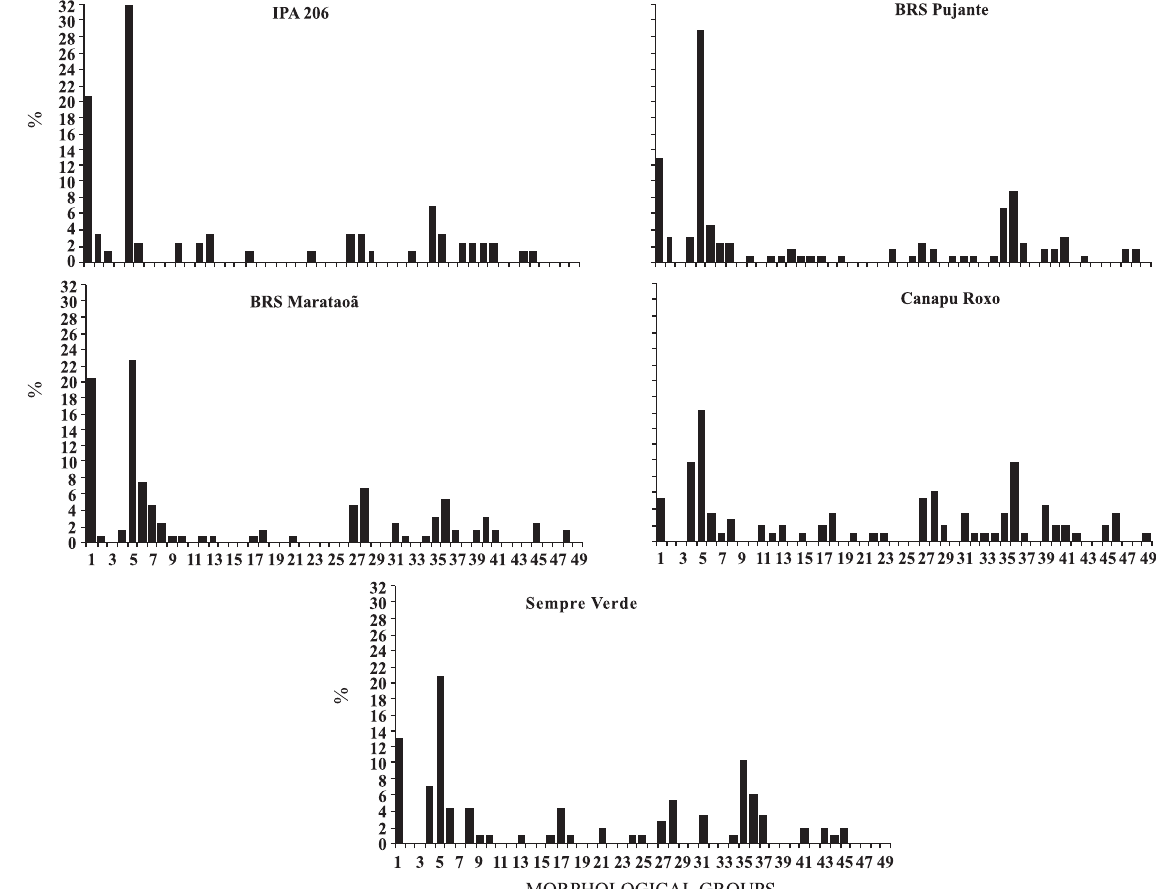
Figure 2. Frequency of rhizobium groups in cowpea cultivars grown in soils of the lower half of the São Francisco river